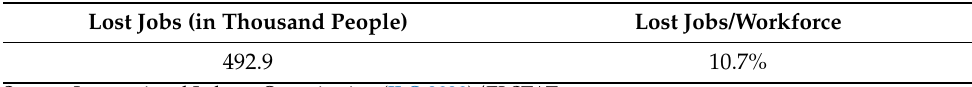
Table 3. Lost working hours due to lockdowns (Greece 2020).